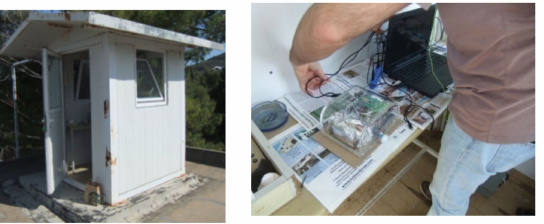
Figure 5. Left : guard post with door and windows. Right : detector device with the sampling tube and the entire measurement